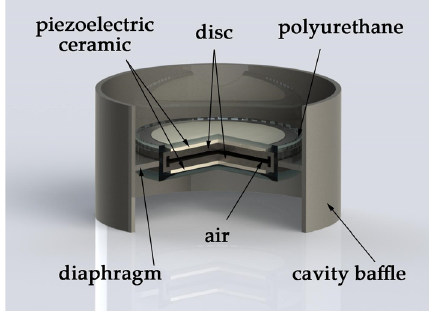
Figure 1. Schematic diagram of transducer.